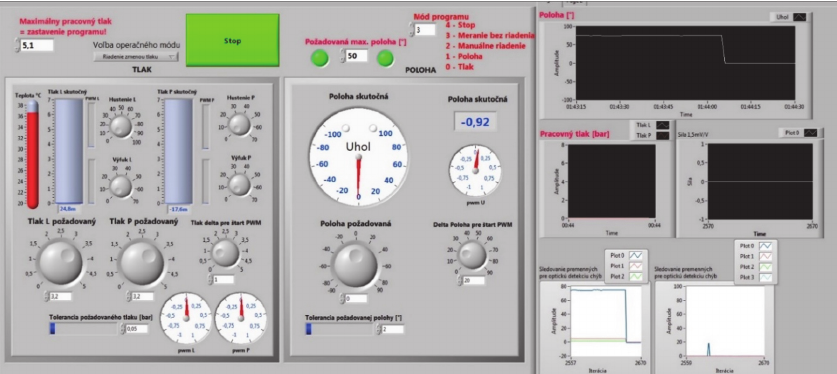
Figure 5: Taskbar of the designed user interface.